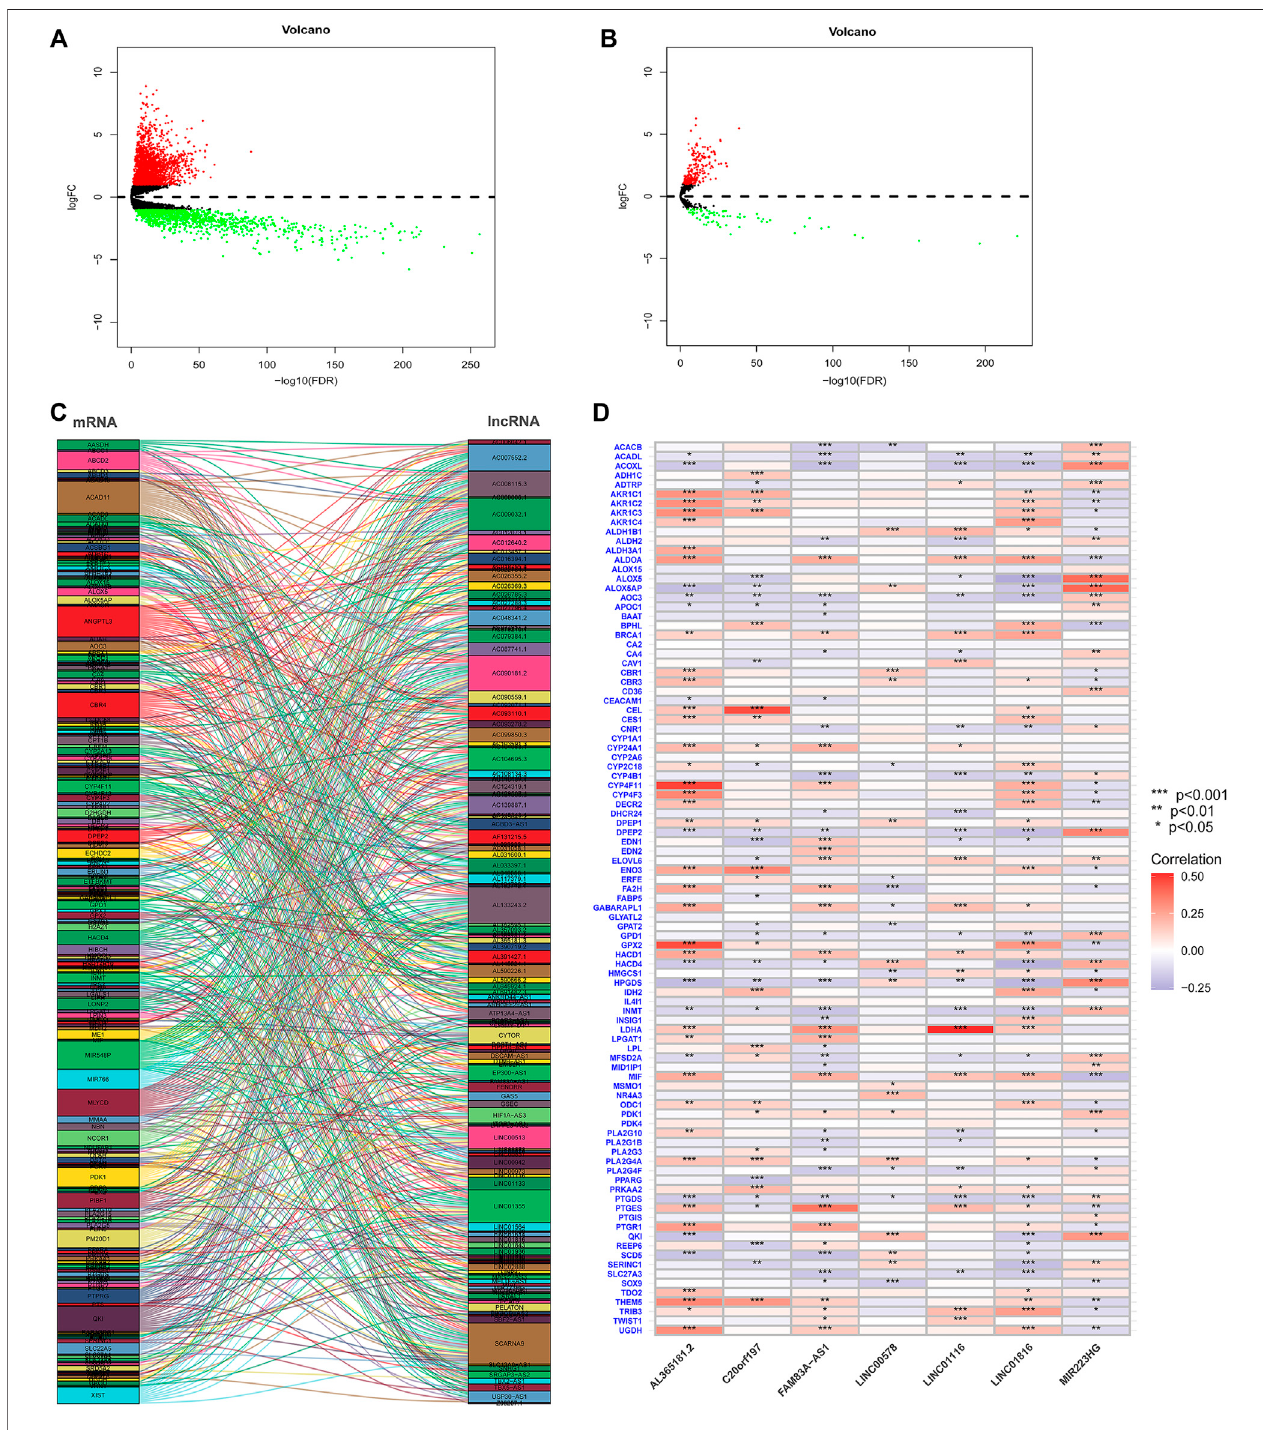
FIGURE 1 | (A) A total of 19,573 differentially expressed mRNAs were analyzed to obtain 3569 signi fi cantly differentially expressed mRNAs (diffmRNAs) (|log 2 FC| > 1, p < 0.05). (B) Differential expression analysis of 14,056 lncRNAs revealed 295 lncRNAs (dif fl ncRNAs) that were signi fi cantly differentially expressed (|log 0.05). (C) Sankey plot of lncRNAs with a signi fi cant correlation between dif fl ncRNA and a gene in FAMdiffmRNA (|corFilter| > 0.4, p < 0.001). (D) Heatmap of the correlation between dif fl ncRNA and FAMdiffmRNA expression.